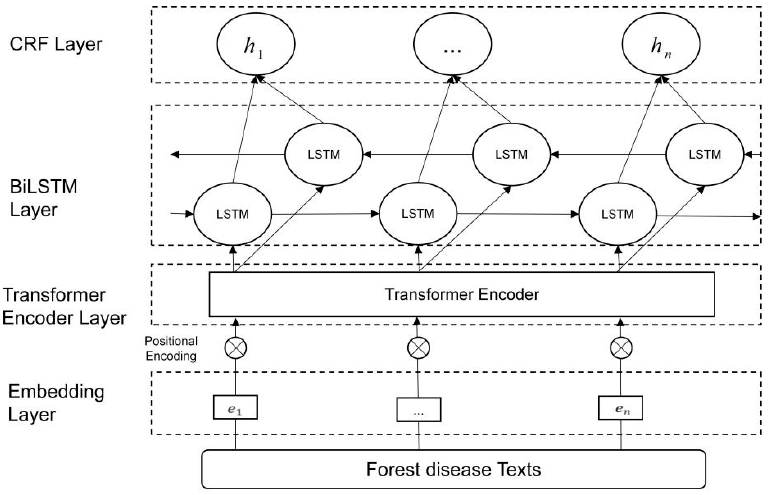
Figure 5. The structure of Transformer-BiLSTM-CRF method.